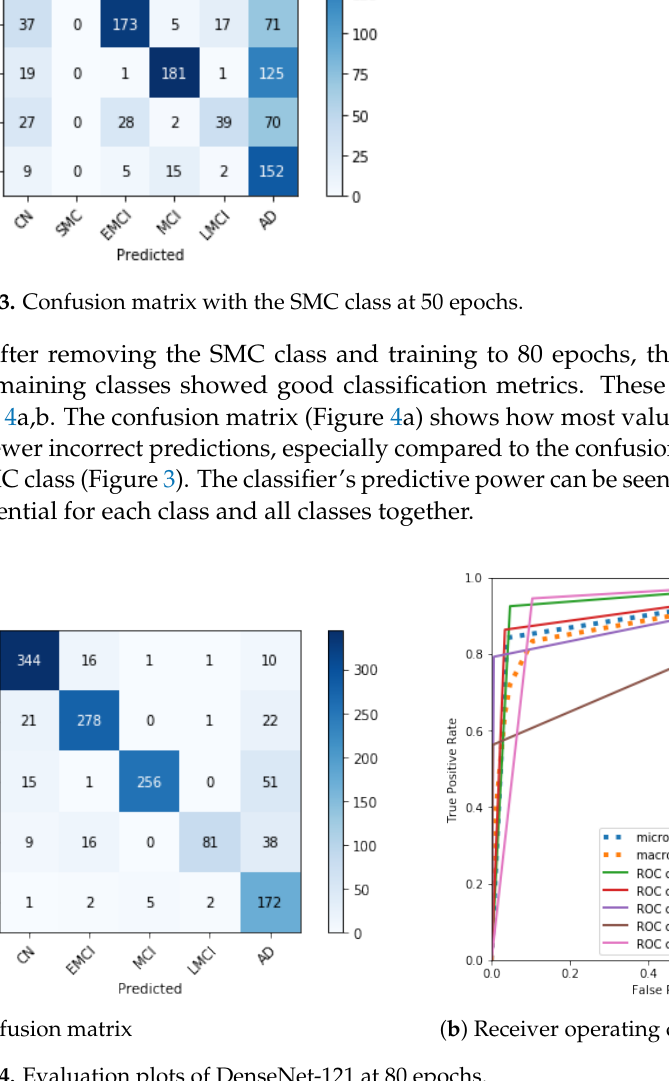
Figure 4. Evaluation plots of DenseNet-121 at 80